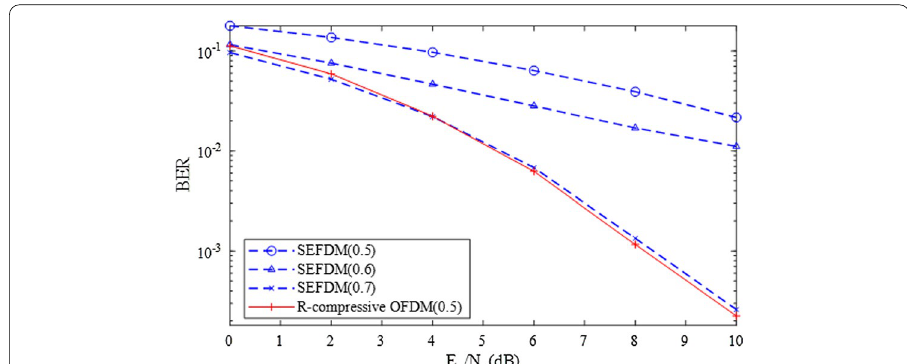
Fig. 7 BER of compressive OFDM and SEFDM with different compressed ratios